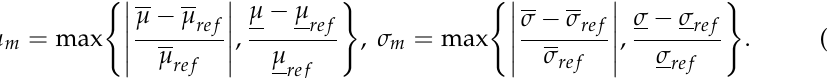
Figure 4. The relative error of mean value and variance for Case 2.